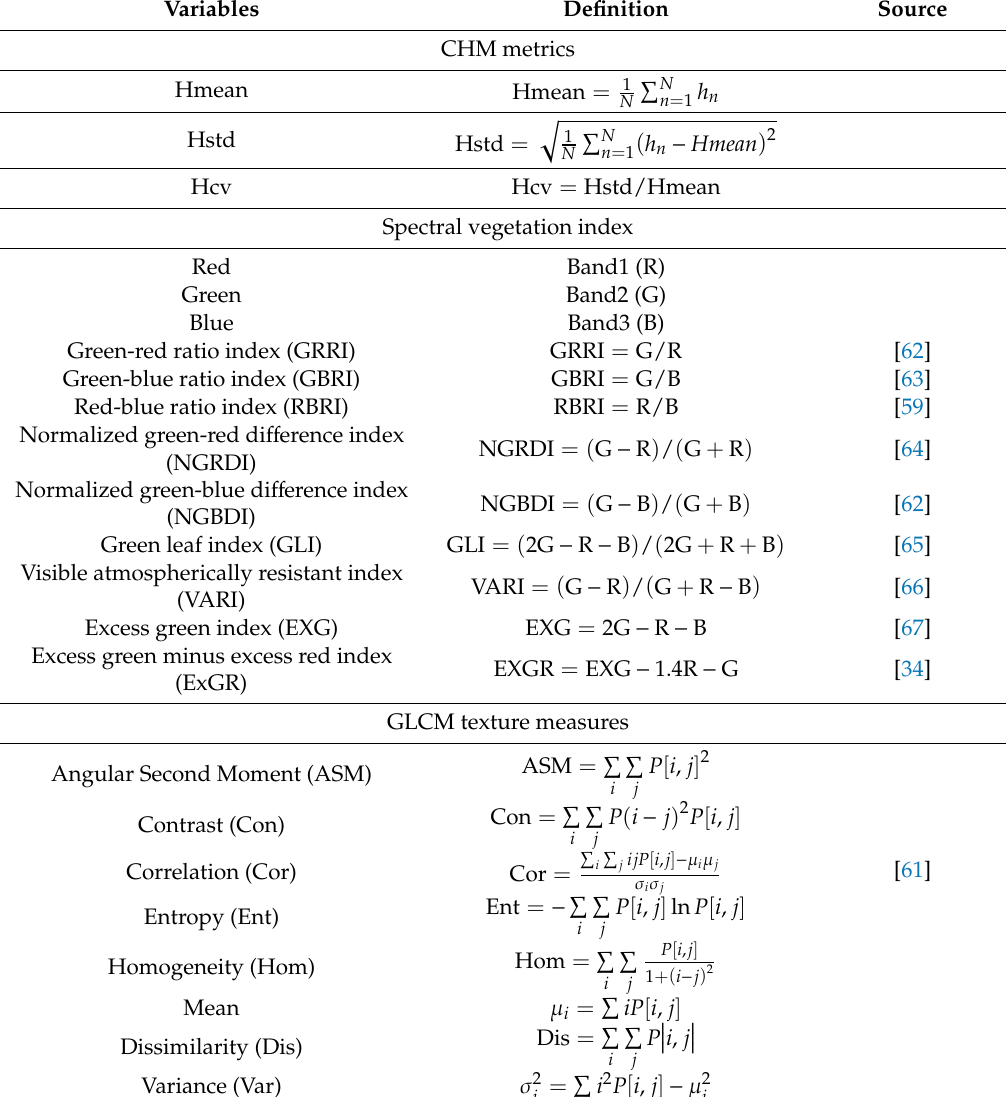
Table 3. Definitions of variables used in this